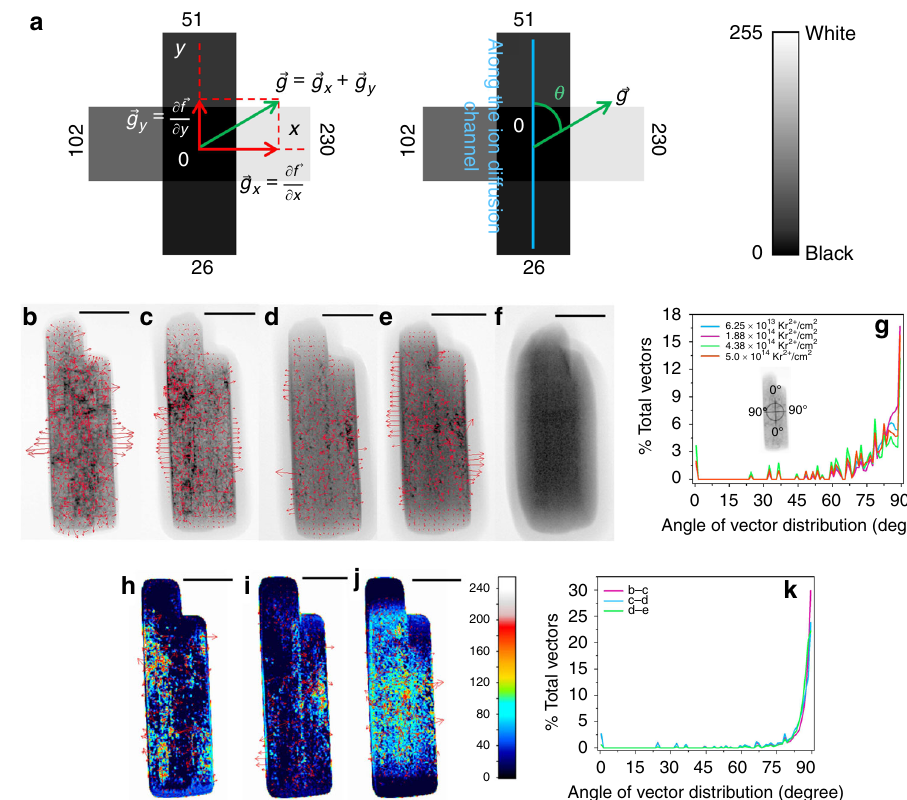
Fig. 4 Defect clusters evolution in Na 2/3 Fe 1/2 Mn 1/2 O 2 under Kr ion irradiation. Grayscale bright- fi eld two-beam images are acquired to study the defect clusters distribution and evolution. a Scheme presenting the calculation of the gradient vector from a certain pixel of a bright- fi eld two-beam image. The gradient vector points to the overall directional change in pixel value. Gradient vector calculated and superimposed on the bright- fi eld two-beam image of a Na 2/3 Fe 1/2 Mn 1/2 O 2 particle irradiated at the total fl uence of b 6.25 × 10 13 Kr 2 + /cm 2 , c 1.88 × 10 14 Kr 2 + /cm 2 , d 4.38 × 10 14 Kr 2 + /cm 2 , and e 5.0 × 10 14 Kr 2 + /cm 2 at room temperature. Bright- fi eld two-beam image of a Na 2/3 Fe 1/2 Mn 1/2 O 2 particle irradiated at the total fl uence of f 6.25 × 10 14 Kr 2 + /cm 2 at room temperature. The bright- fi eld images are taken from the [100] zone axis. All the scale bars in the image b – f correspond to a length of 100 nm. g Distribution of the gradient vectors of image b – e against the angle of the gradient vector. The inset shows the scheme of how the angle of the gradient vector is de fi ned. Dynamic defect evolution in a Na 2/3 Fe 1/2 Mn 1/2 O 2 particle with increasing fl uence of Kr ion irradiation ( h – j ). The dynamic defect evolution is studied through the subtraction of the image acquired at higher irradiation dose from that of the lower irradiation dose (e.g., image c subtracted from image b). Defect evolution from h image b – c, i image c – d, and j image d – e. All the scale bars from images h – j correspond to a length of 100 nm. The color bar shows the corresponding values of the subtracted pixels after the subtracted grayscale image is converted to an RGB image. k Distribution of the gradient vectors of images h – j against the angle of the gradient